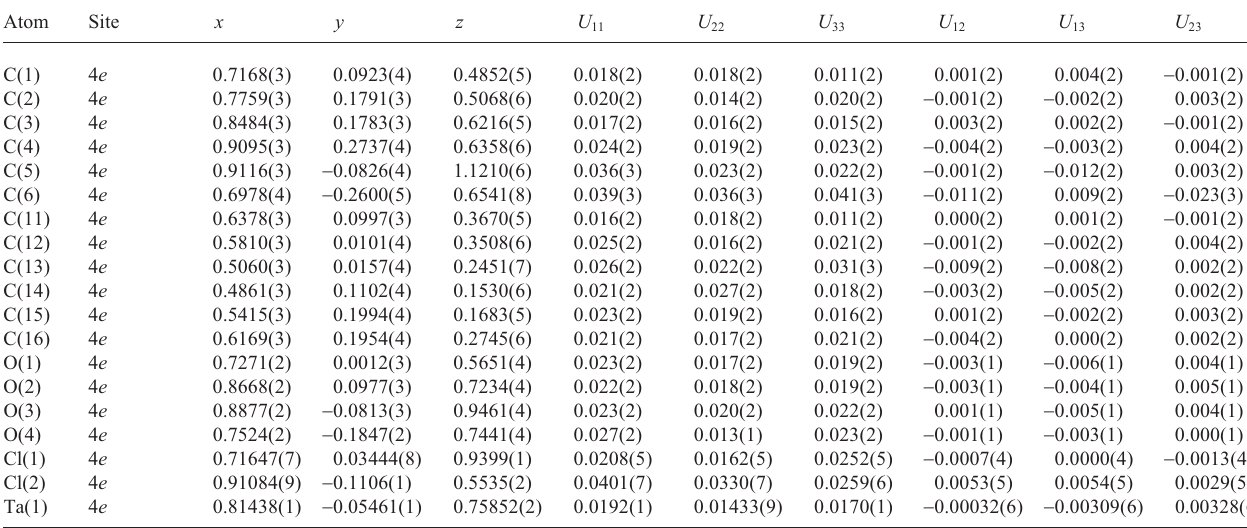
Table 3. Atomic coordinates and displacement parameters (in Å 2 )